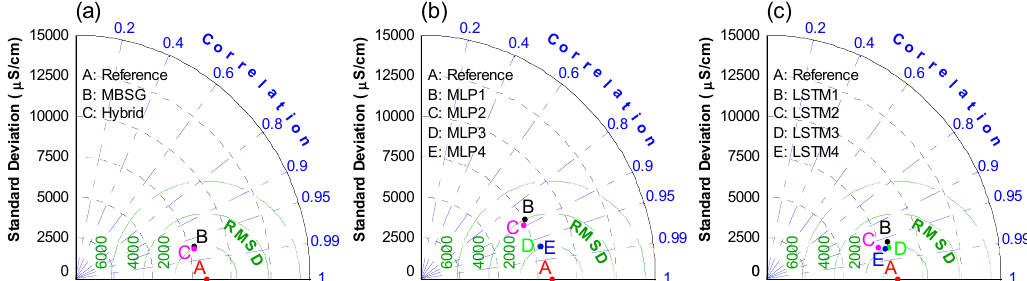
Figure 3. Taylor Diagrams illustrating the correlation (R; the azimuth position), standard deviation (SD; radial distance from the origin, shown on both vertical and horizontal axes), and centered root mean square difference (RMSD; radial distance from the reference point A which serves as the origin for RMSD) between the reference salinity at Martinez and the corresponding salinity simulations generated via ( a ) MBSG and hybrid MBSG–CNN models, ( b ) four MLP models, and ( c ) four LSTM models. Reference point A designates the statistics of the reference salinity itself (RMSD = 0; R = 1). The X -axis shows the values of both SD and RMSE of which the ticks are different.